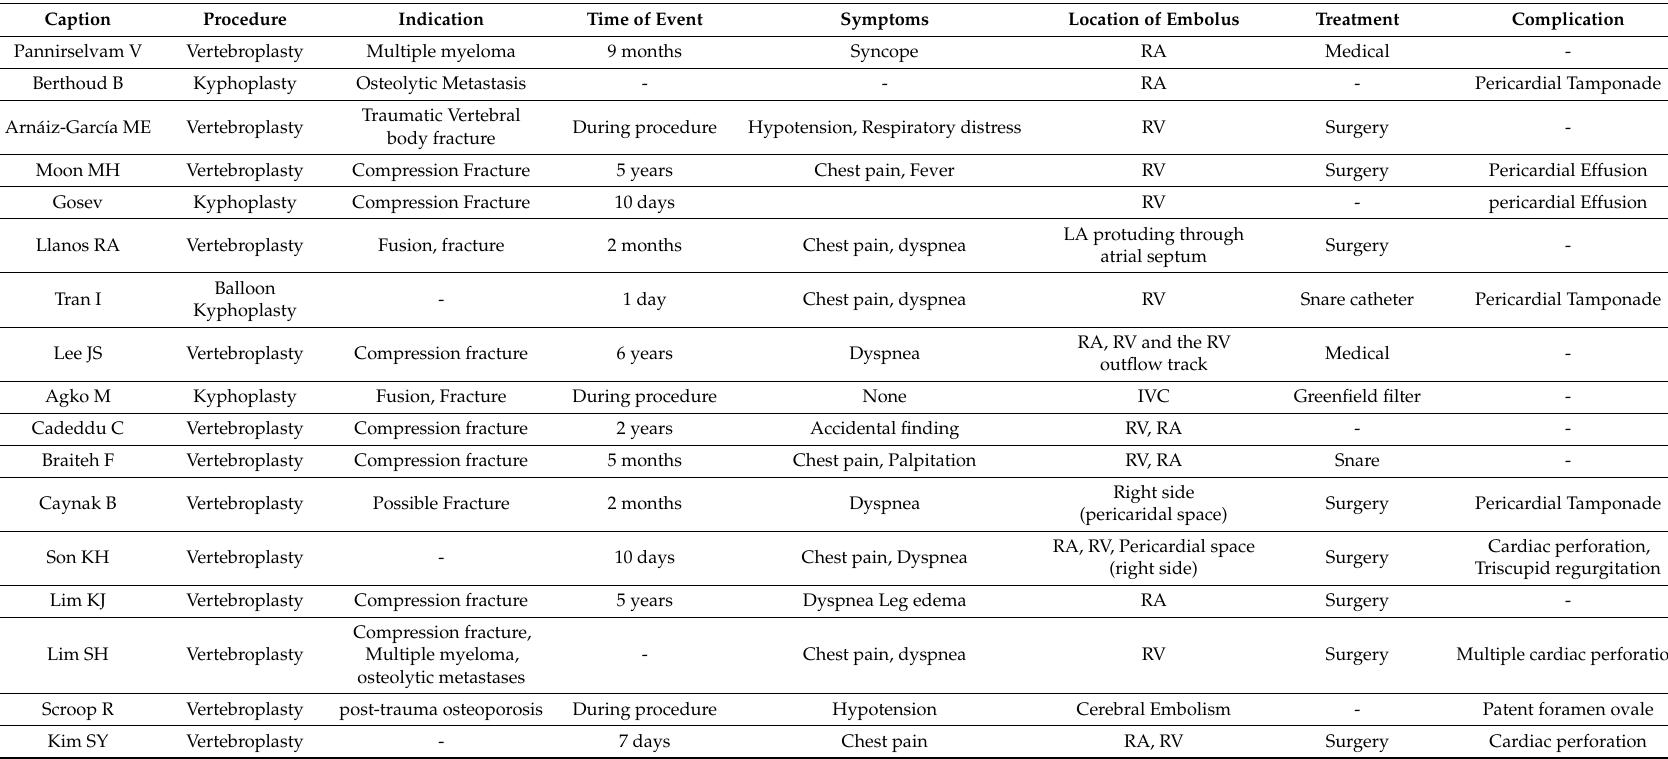
Table 2. Literature review on Intra Cardiac Emboli (ICE) located in various regions of the heart including the Right Ventricle (RV), Right Atrium (RA), Left Atrium (LA), and Inferior Vena Cava